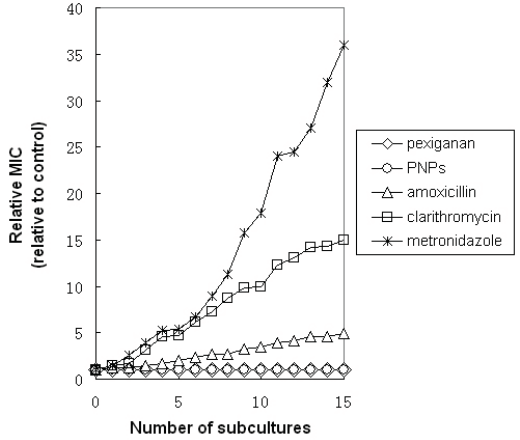
Figure 2. In vitro development-of-resistance studies. Evolution of MICs after successive exposures of H. pylori to subinhibitory concentrations of the antimicrobial agent. After 15 serial passages, the relative MIC was the normalized ratio of the MIC obtained for a given subculture to the MIC that obtained for first-time